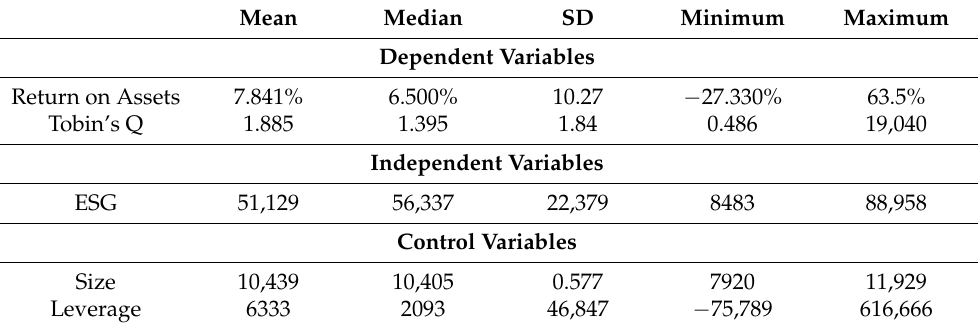
Table 4. Descriptive